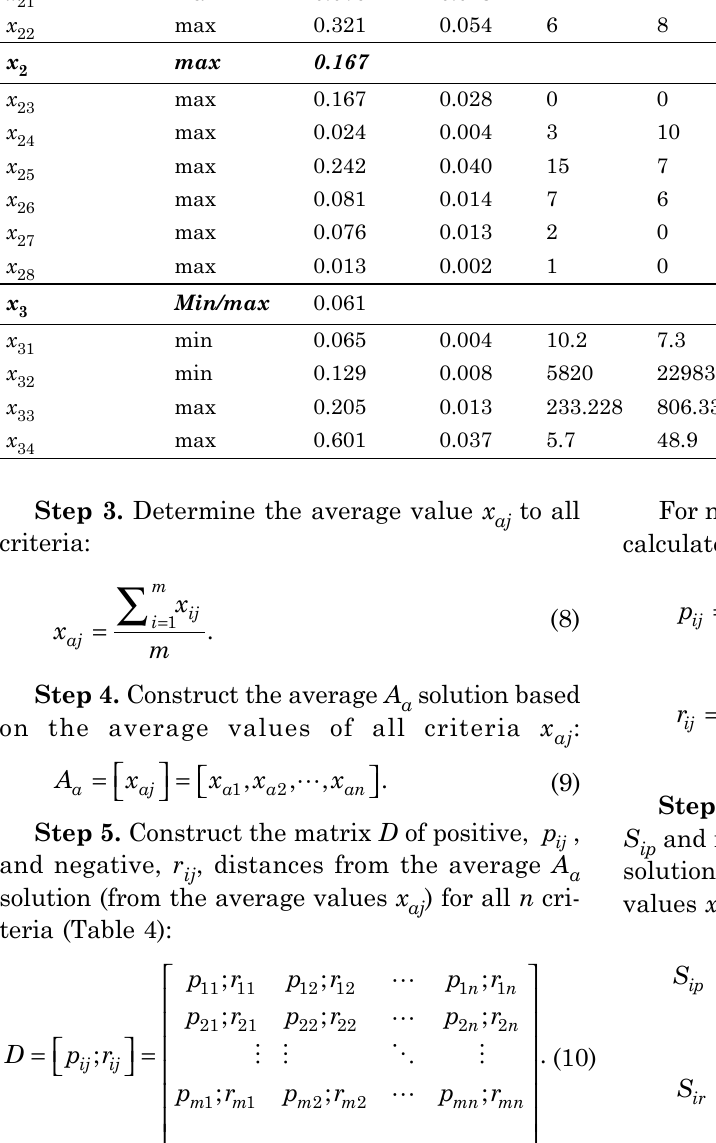
Optimal Weights (based on